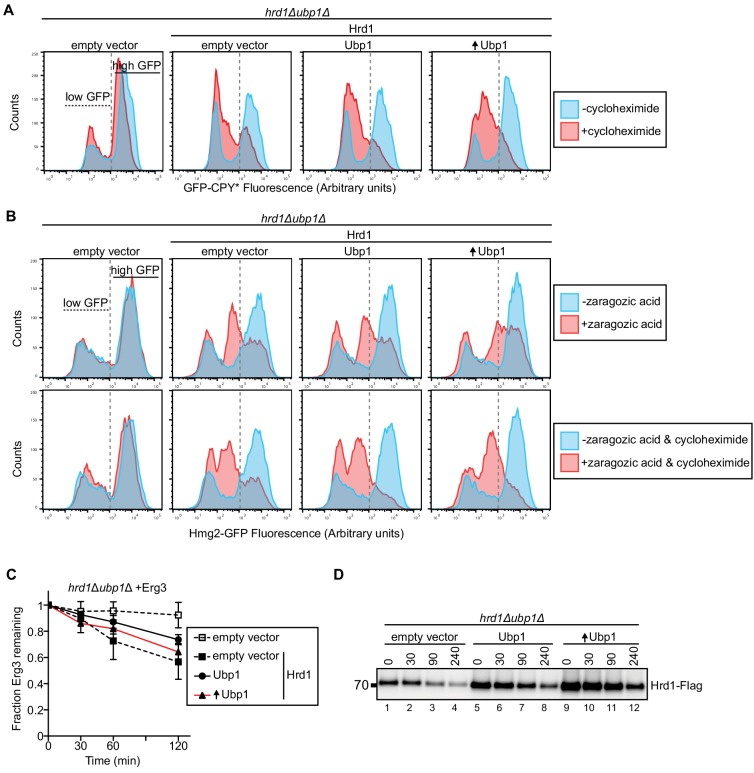
Ubp1 manipulates Hrd1 activity.(A) GFP-CPY* was expressed from a centromeric plasmid under the GPD promoter in a hrd1Δubp1Δ strain. GFP-CPY* degradation was followed in cycloheximide-chase experiments. The indicated additional proteins were expressed from centromeric plasmids under their endogenous promoters or GPD promoter, indicated by upward arrow. Samples were analyzed by flow cytometry after 4 hr of treatment. The number of cells expressing low levels of GFP (horizontal dashed line) does not change during cycloheximide treatment, whereas those highly expressing GFP-CPY* changes (horizontal solid line). This panel is representative of at least three experiments. (B) As in (A) but with a centromeric plasmid containing Hmg2-GFP driven by the GPD promoter. Degradation was stimulated using zaragozic acid or combination of zaragozic acid and cycloheximide. This panel is representative of at least three experiments. (C) The degradation of Erg3-Flag was followed by cycloheximide chase in a hrd1Δubp1Δ strain containing the indicated proteins under endogenous promoter or GPD promoter, indicated by upward arrow. The data are the mean + /- SEM from at least three experiments. (D) As in (C) but following degradation of Hrd1-Flag in hrd1Δubp1Δ cells expressing CPY*-HA with the indicated proteins. This panel is representative of at least three experiments.